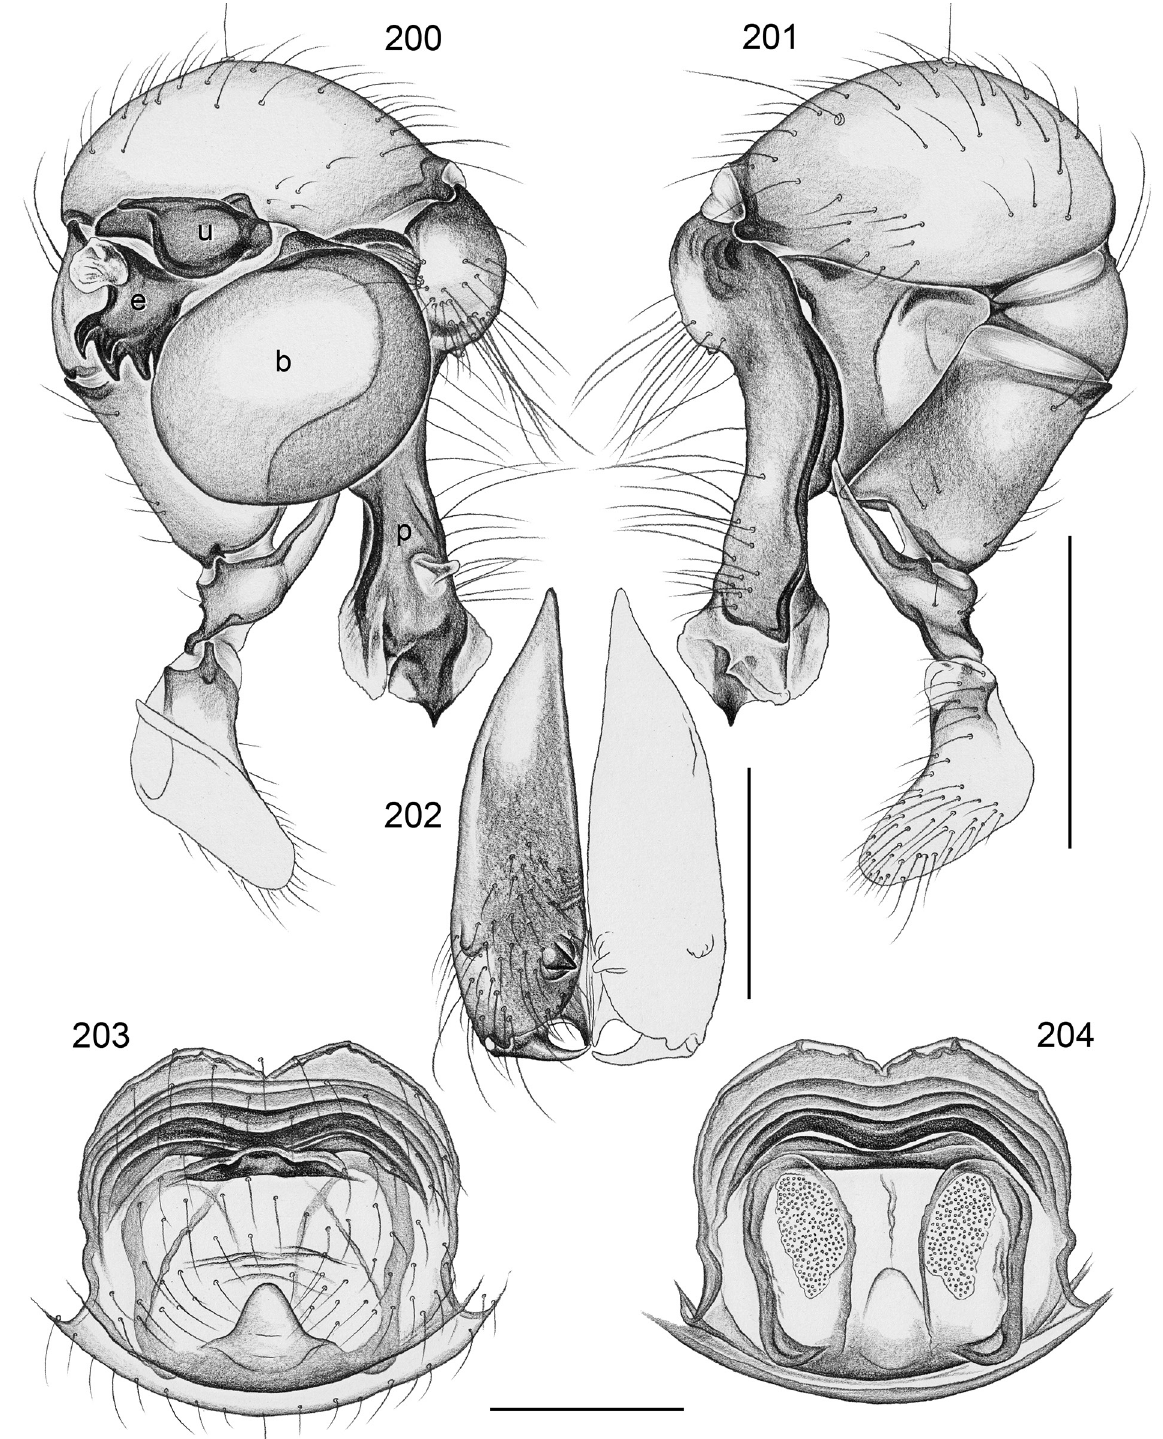
Figs 200–204. Pholcus lambir Huber, sp. nov., ZFMK Ar 15060–61. 200–201 . Left male palp, prolateral and retrolateral views. 202 . Male chelicerae, frontal view. 203–204 . Cleared female genitalia, ventral and dorsal views. Abbreviations: b = genital bulb; e = embolus; p = procursus; u = uncus. Scale lines: 0.3 mm (202–204), 0.5 mm